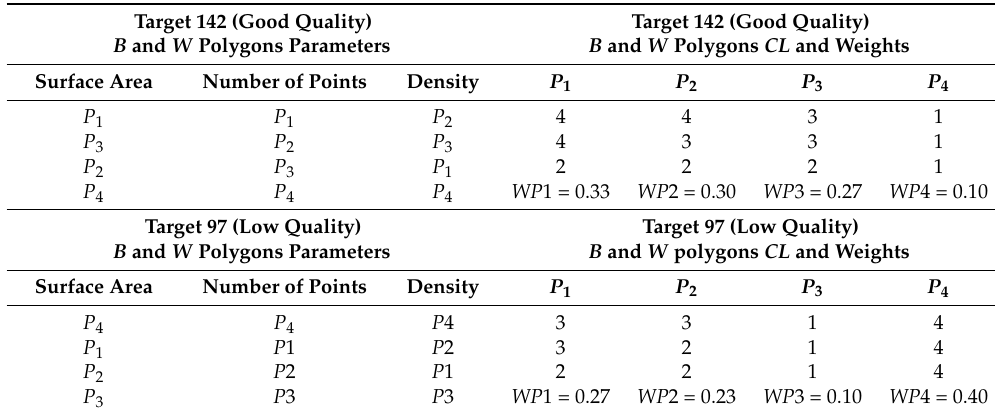
Table 3. List of parameters for individual fields for regular, good quality target scans (142) and for irregular, incomplete target scans (97).